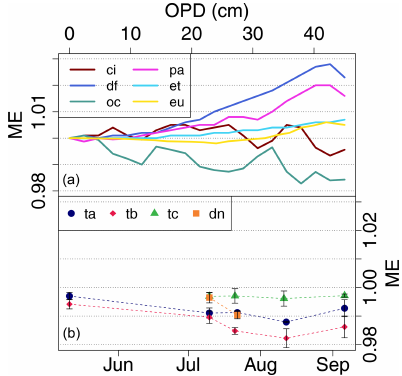
Figure 2. Modulation efficiency of TCCON instruments at differ- ent OPD (0–45cm, x axis, a ) and EM27/SUN devices at maximum OPD (1.8cm) over time (May 2018 to September 2018, x axis, b